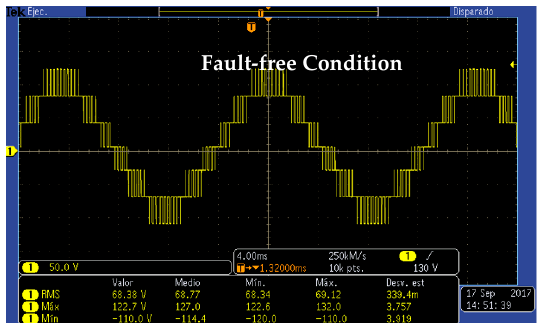
Figure 13. Oscillogram of the seven-level cascade multilevel inverter output voltage waveform in fault-free condition.